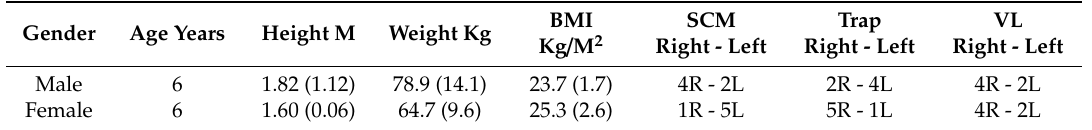
Table 1. Characteristics of the